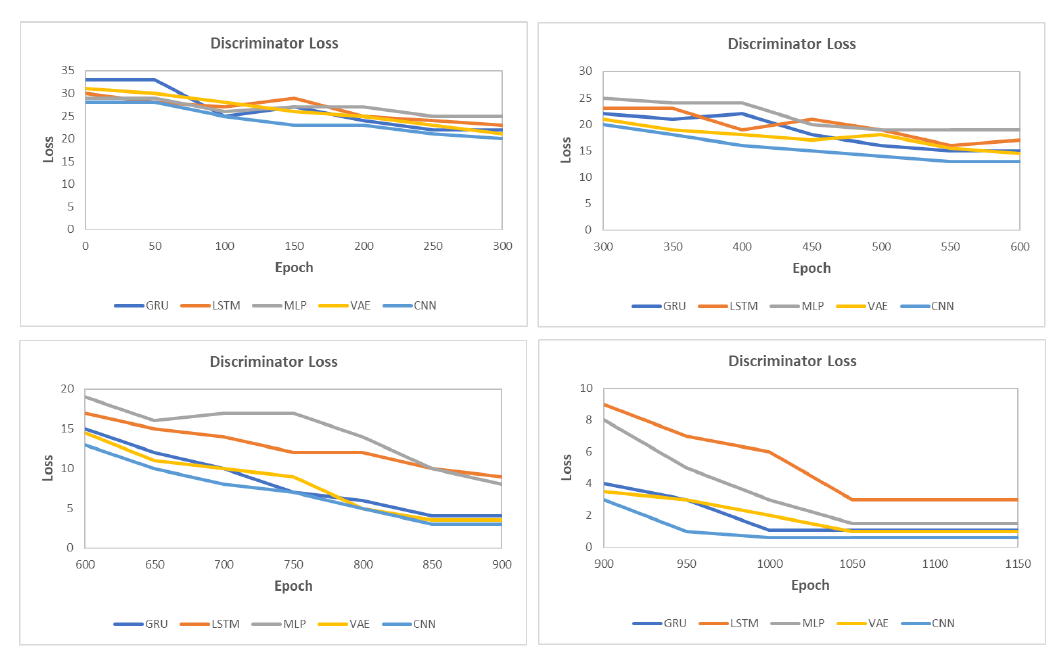
Figure 13. Loss for different discriminators with BiGridLSTM as the generator in the GAN